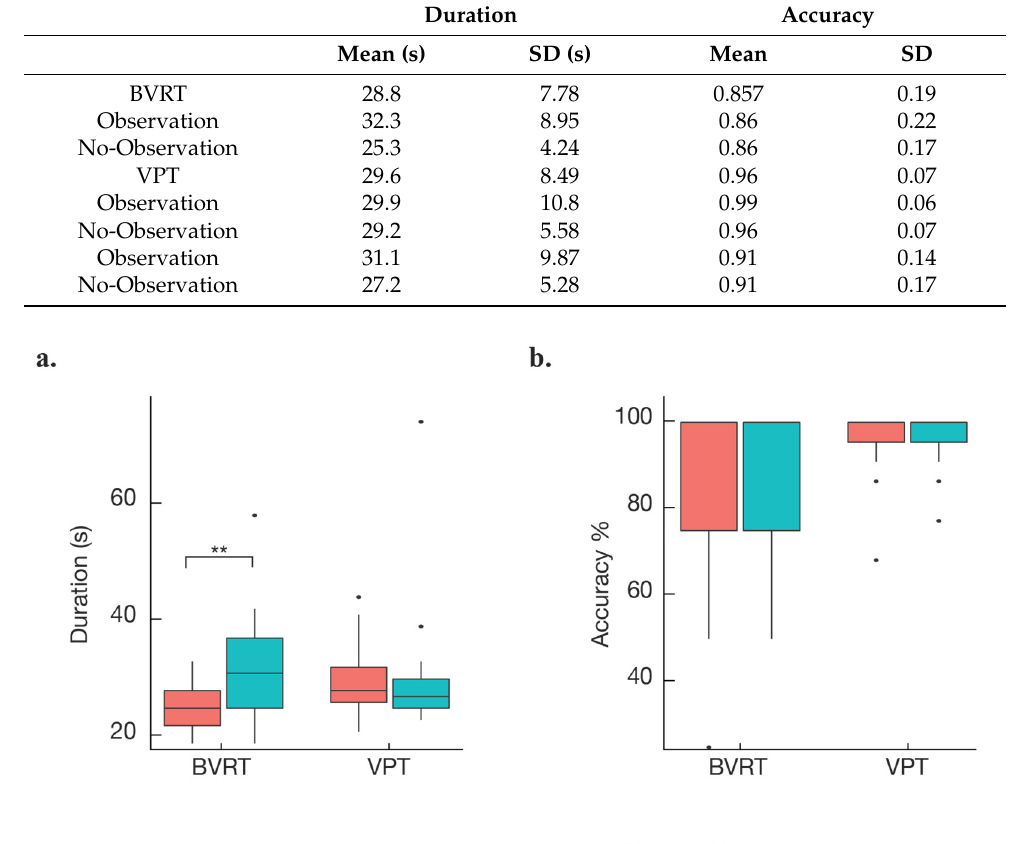
Table 1. Summary of behavioral data with means and standard deviations of task duration and accuracy for each of the two experimental conditions as well as by task format condition and observational condition.